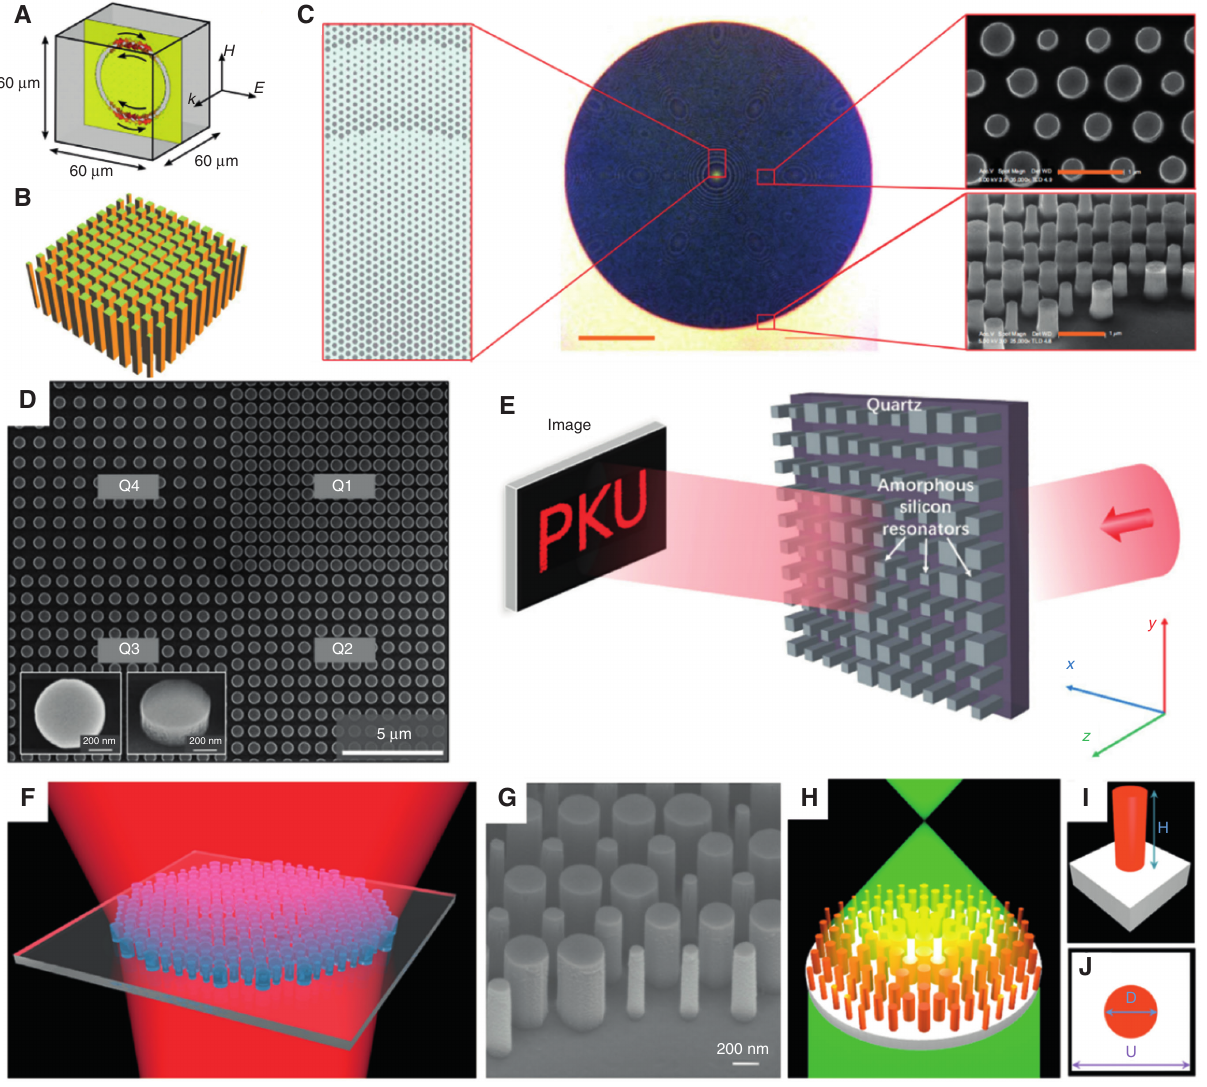
Figure 3: Isotropic nanostructured metasurfaces. (A) Metallic annular slots [20]. (B) Metalens based on metallic nanoscale pillars [21]. (C) Metalens based on silicon nanoposts with